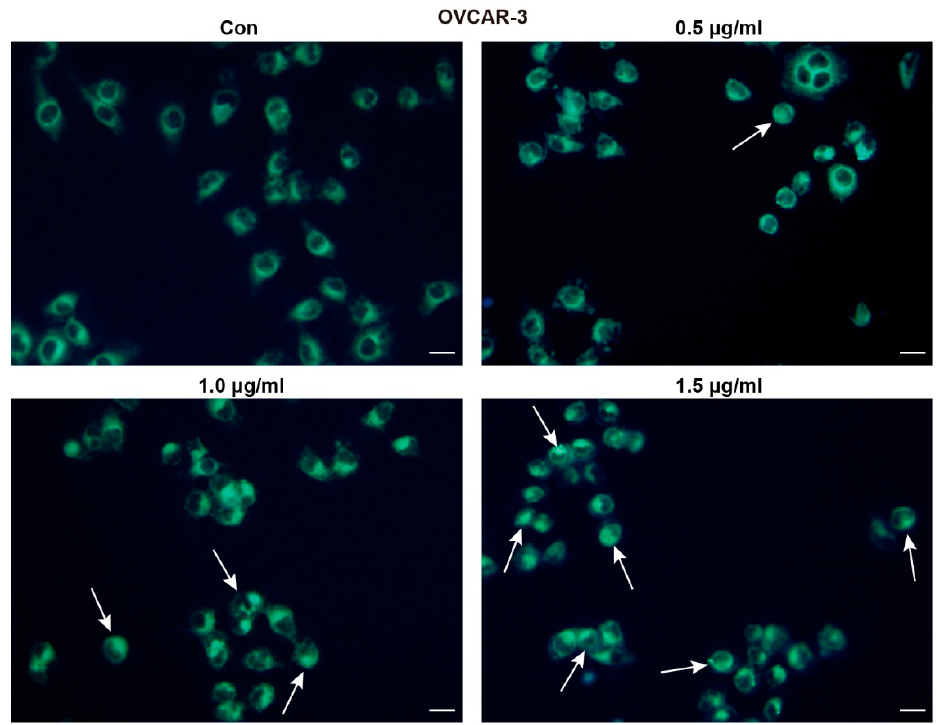
Figure 3. TFS induced autophagic vacuoles in OVCAR-3 cells. OVCAR-3 cells were treated with TFS (0, 0.5, 1.0 and 1.5 μ g/mL) for 24 h then stained with MDC dye and visualized by fluorescence microscopy. White arrows indicate autophagic cells (magnification 20×), scale bar = 20 μ m.